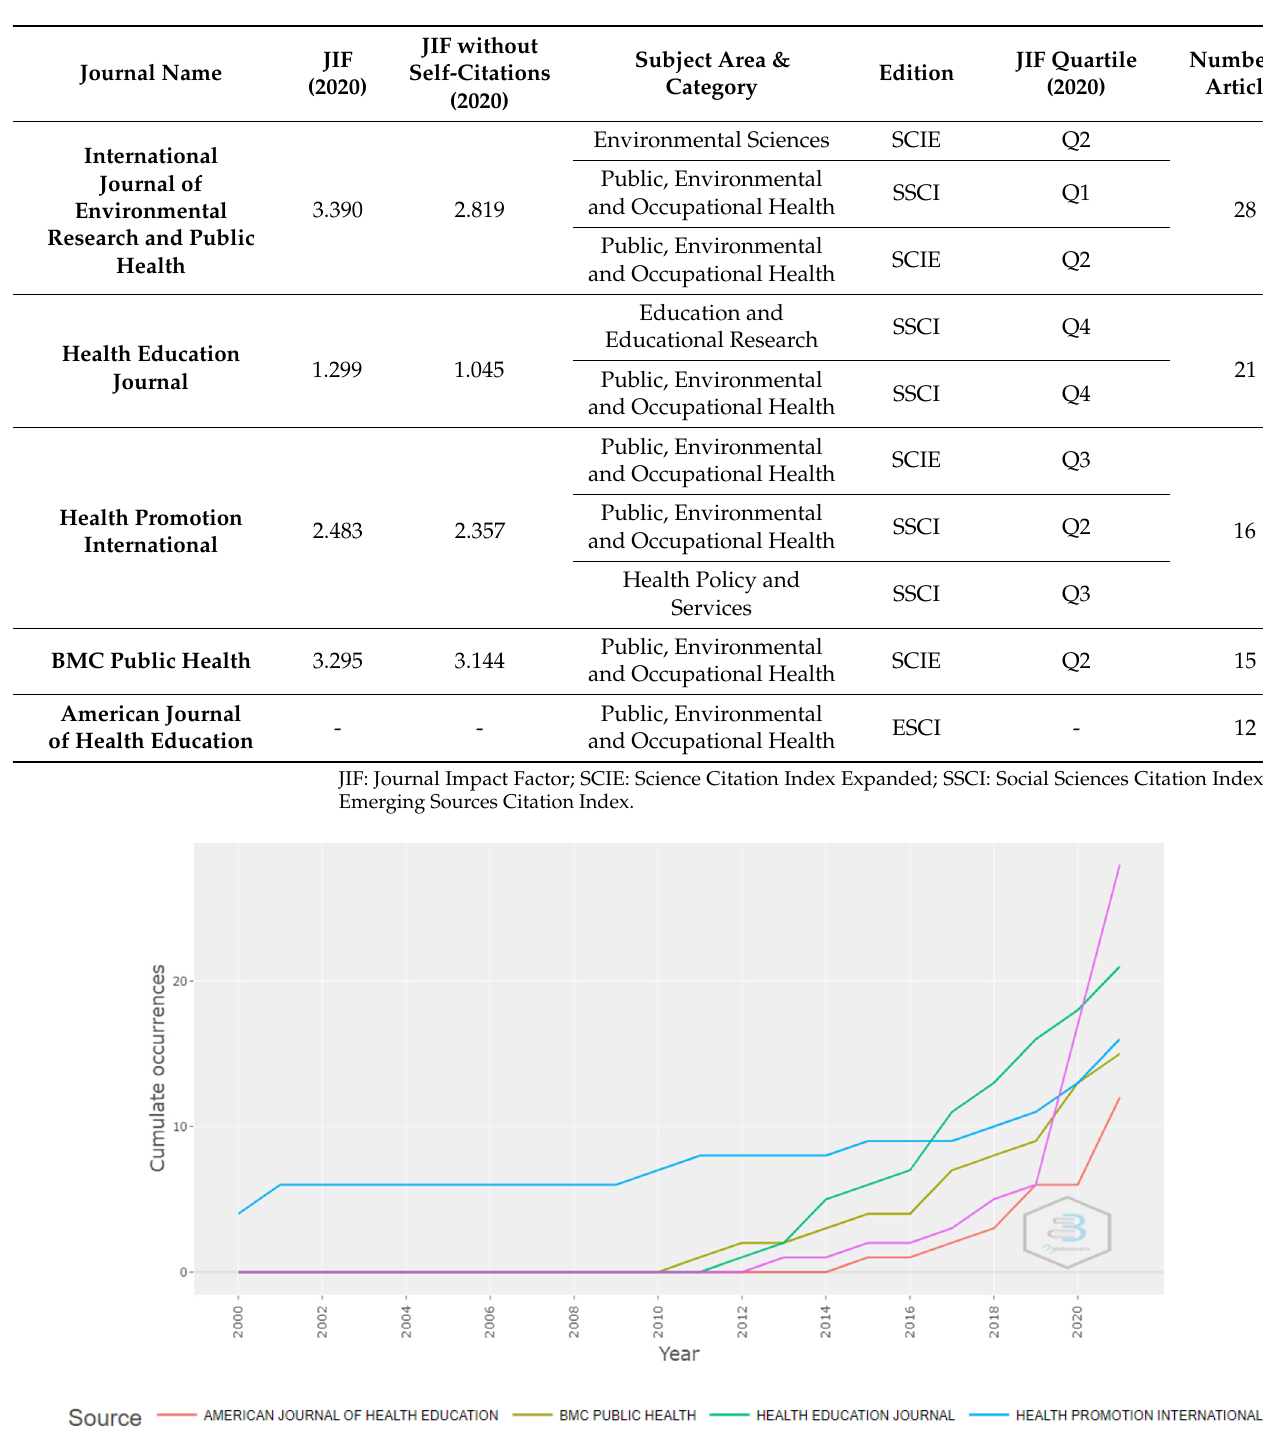
Table 4. Characteristics of the five journals with the most publications in the Web of Science Core Collection.